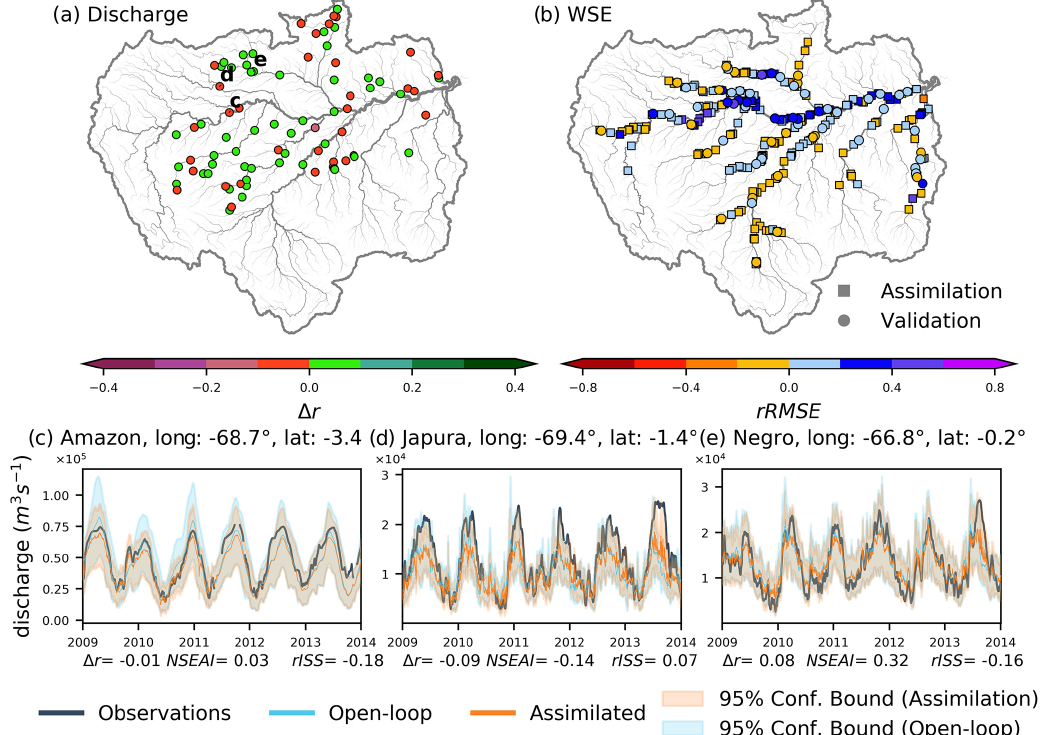
Figure 6. (a) Difference in the correlation coefficient of river discharge ( (cid:49) r) and (b) the relative root mean square error (rRMSE) of water surface elevation for NOM. Circles indicate virtual stations used for data assimilation, and squares are virtual stations used for validation in the WSE plots. Hydrographs recorded at Sao Paulo De Olivenca on the Amazon River, Vila Bittencourt on the Japura River, and Curicuriari on the Negro River are presented in panels (c) , (d) , and (e) , respectively. The locations of the hydrographs shown in panels (c) , (d) , and (e) are presented in panel (a) . Discharge observations are in black, assimilated simulation results are in orange, and open-loop simulation results are in blue. The color range indicates the 95% confidence interval used to calculate the relative interval skill score (rISS). (cid:49) r , the Nash–Sutcliffe efficiency-based assimilation index (NSEAI), and rISS are shown at the bottom of each